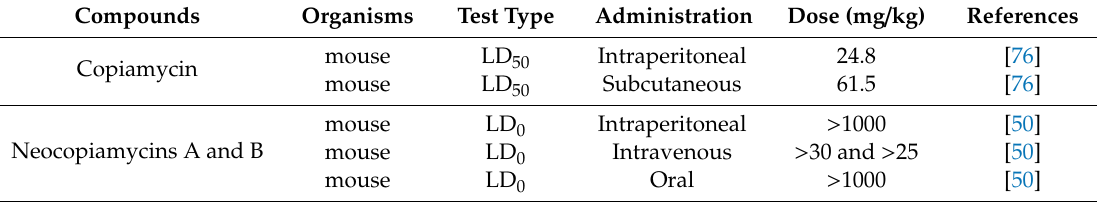
Table 4. The acute toxicities of some guanidine-containing polyhydroxyl